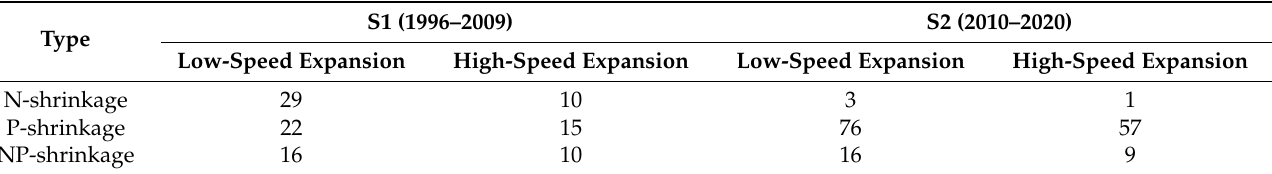
Table 2. The human settlements expansion rate of shrinking cities in